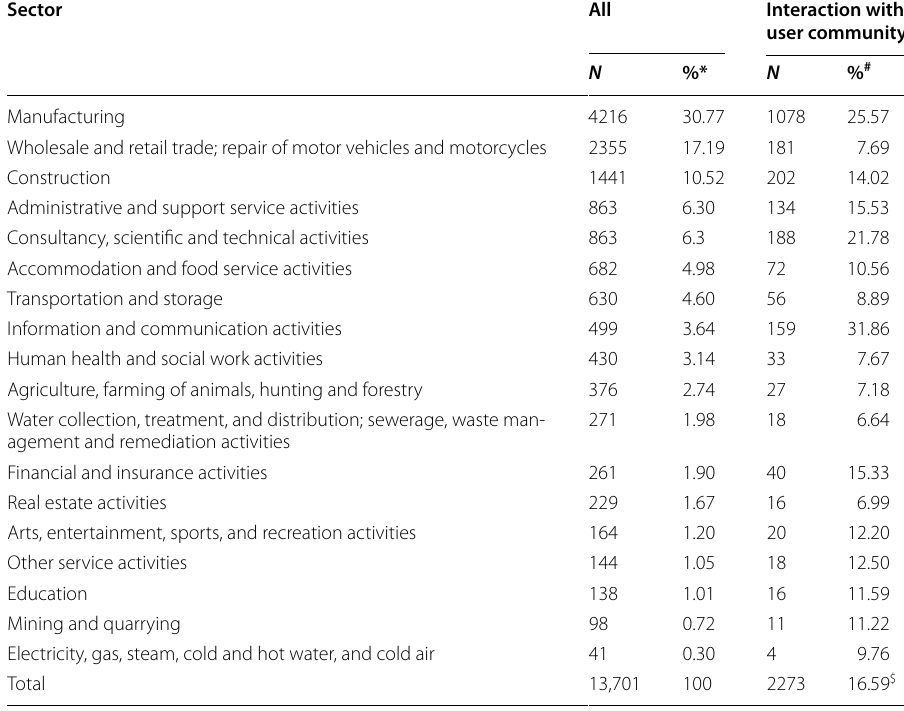
*In the total number of respondents # In the total number of respondents that interact with User Communities $ Percentage in the total number of respondents